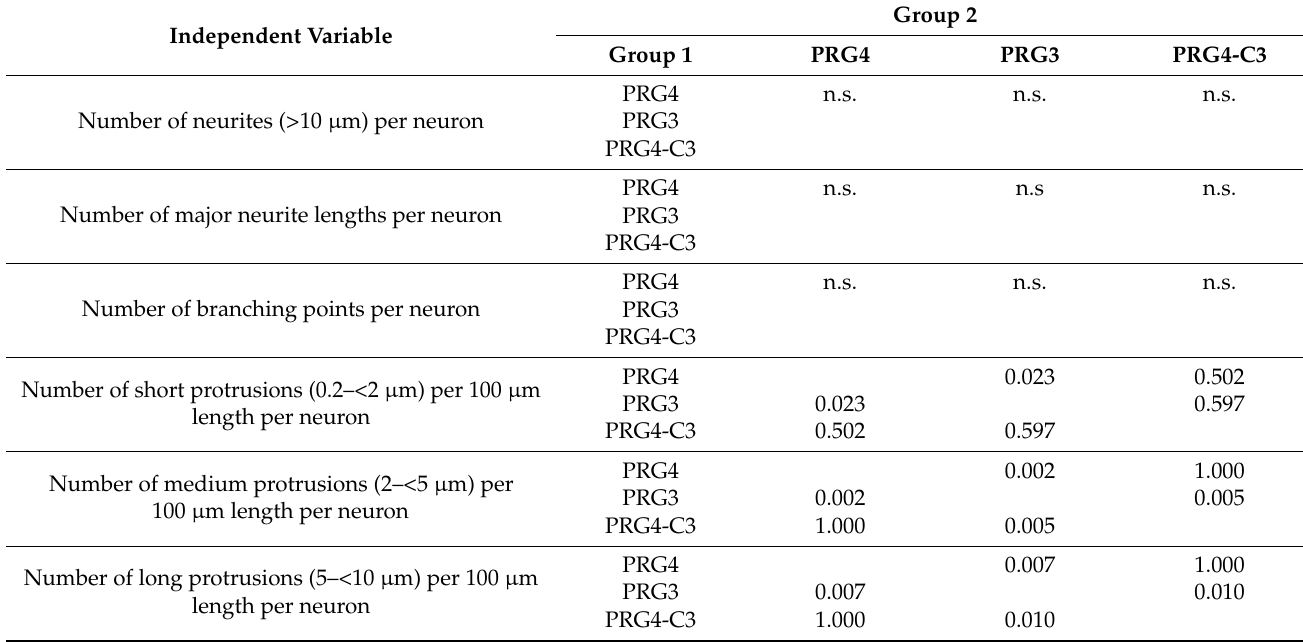
Table 3. Summary of p values of pairwise comparisons obtained by the Kruskal–Wallis test followed by a post hoc Dunn’s test of data presented in Figure